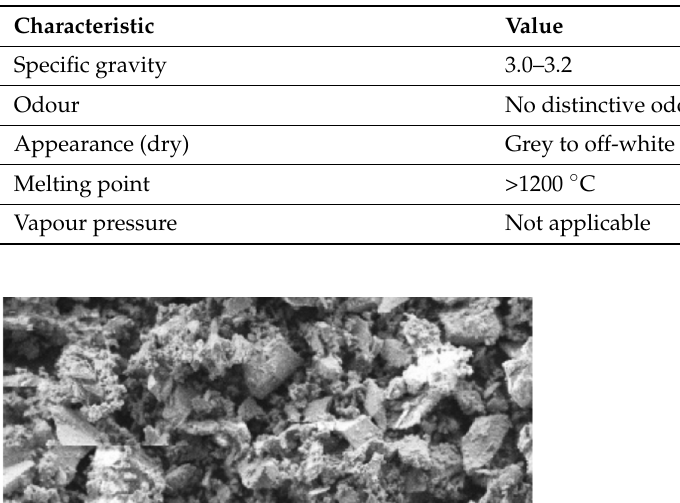
Table 2. GGBFS characteristics (Australia Cement [19]).